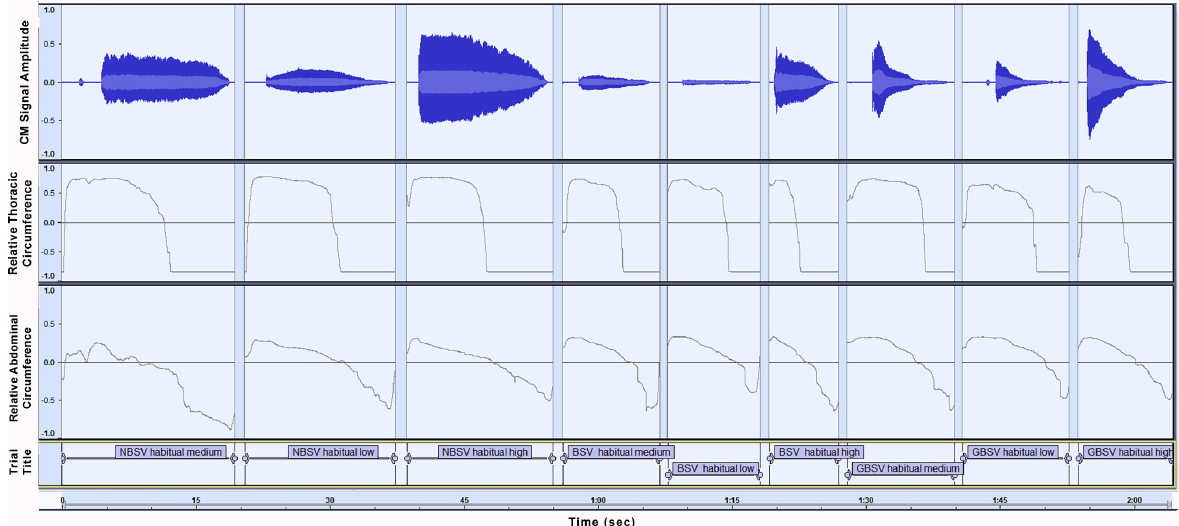
Figure 10. Graph of the nine initial trials for Participant 2 (P2). Sensors and trials illustrated are as described in corresponding Figure 9 for